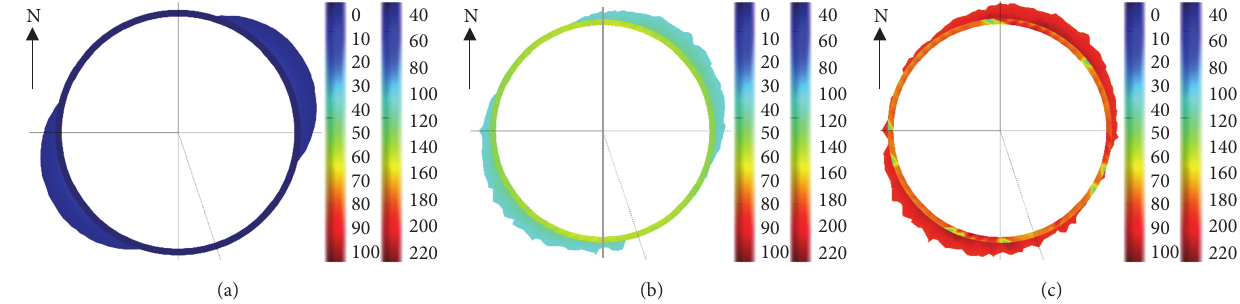
Figure 13: First principal stress [MPa] at − 3 m level resulting from (a) 0 weeks in situ stress, (b) 9 weeks of heating, and (c) 16 weeks of heating using the EDZ and VT1 stress interpretation. The left scale is for the concrete and the right scale is for the surrounding rock mass.